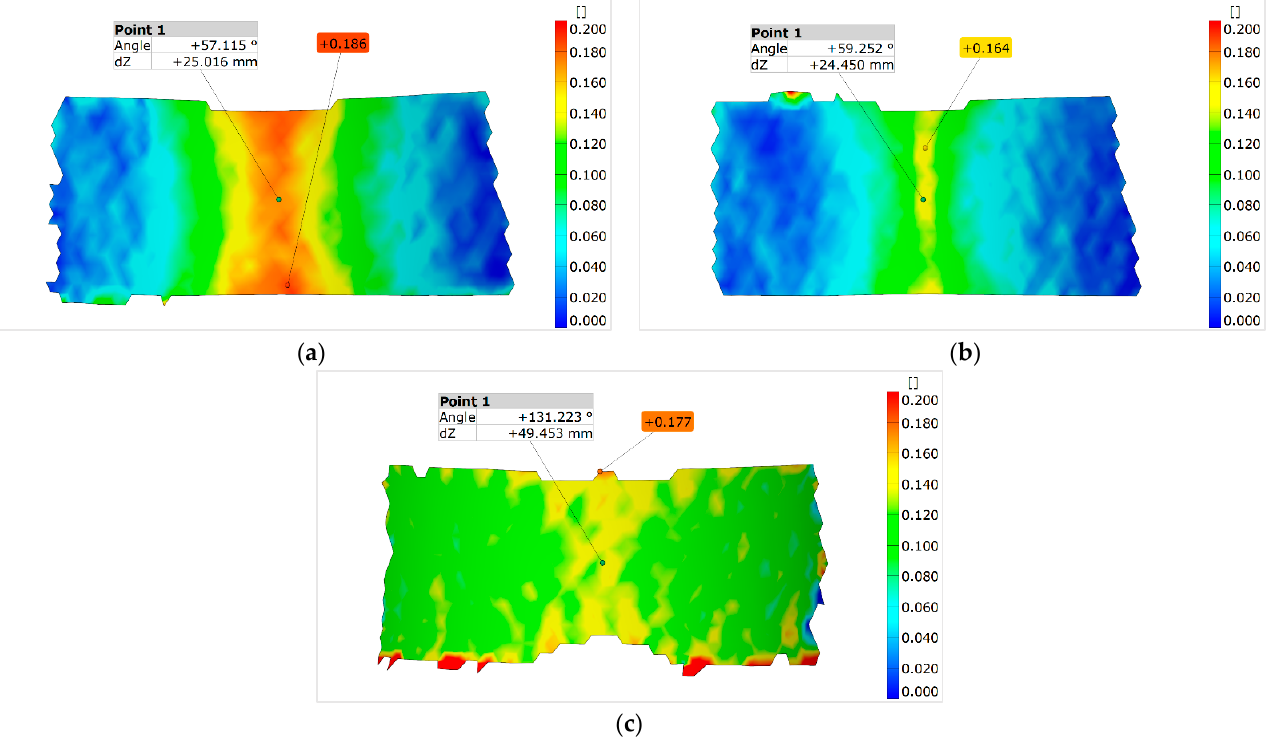
Figure 10. True strain field before fracture initiation of 5 mm test specimens; ( a ) R10; ( b ) R15; ( c ) R20.